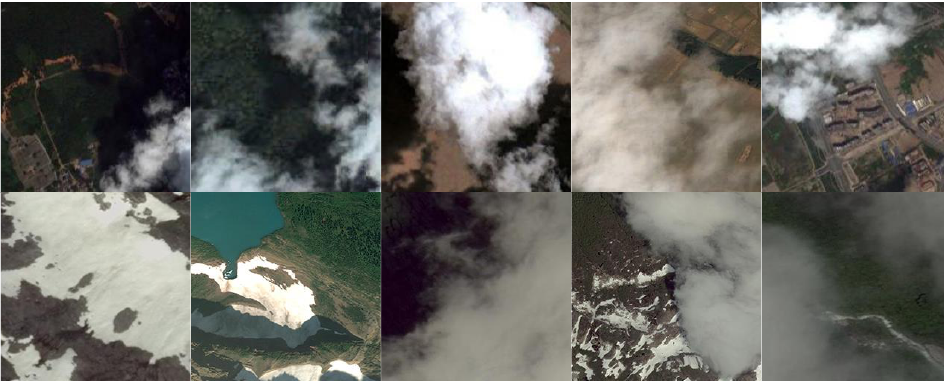
Figure 7. The first line is some training data of the Cloud and Cloud Shadow Dataset, and the second line is some training data of the